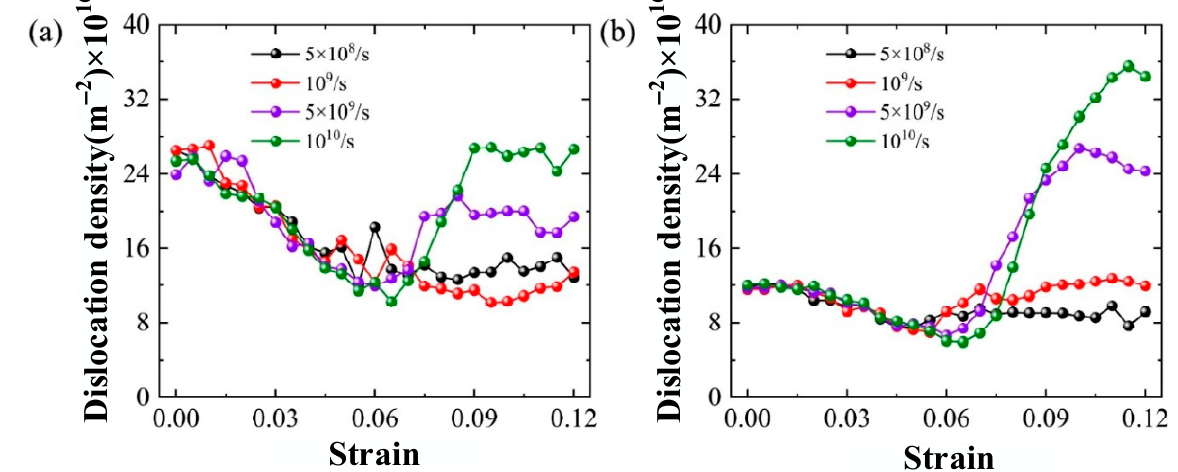
Figure 17. The dislocation density of the samples with various grain sizes. ( a ) grain size d = 7.0 nm, ( b ) grain size d = 16.0 nm.